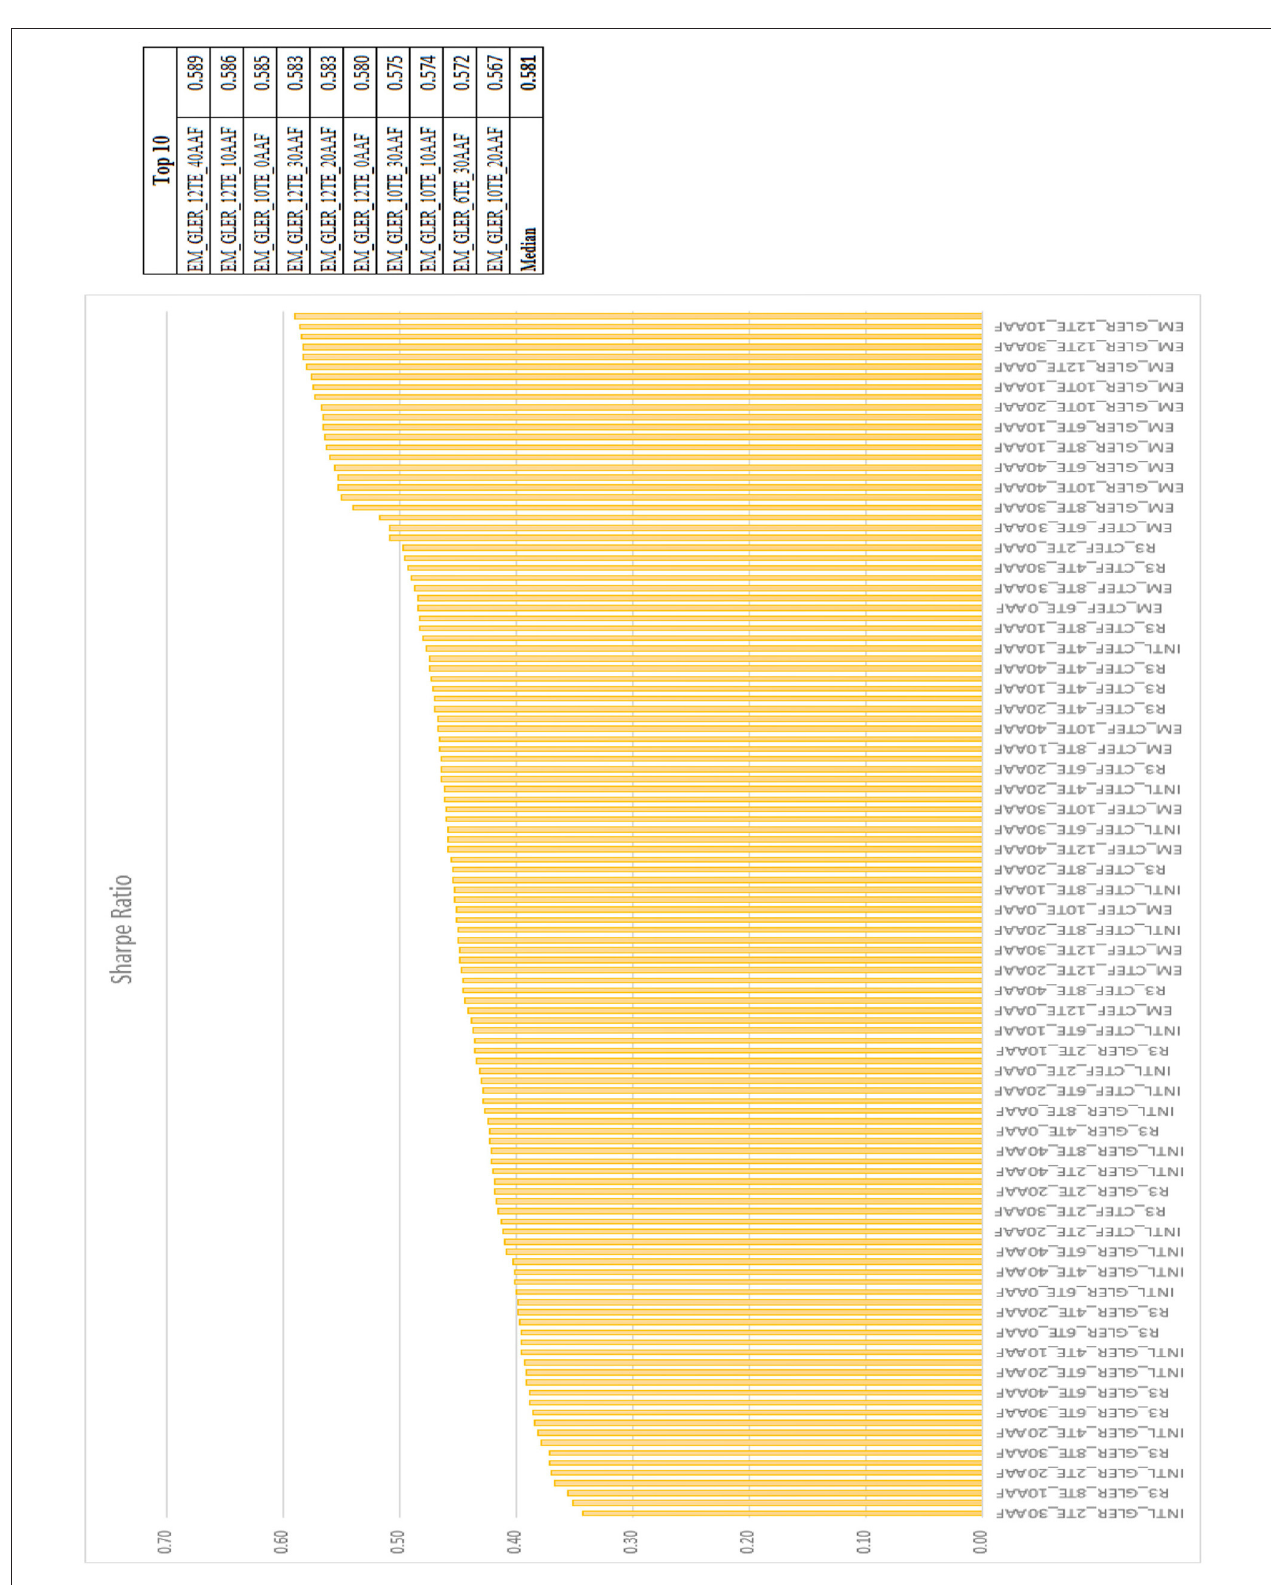
FIGURE 6 | Sharpe